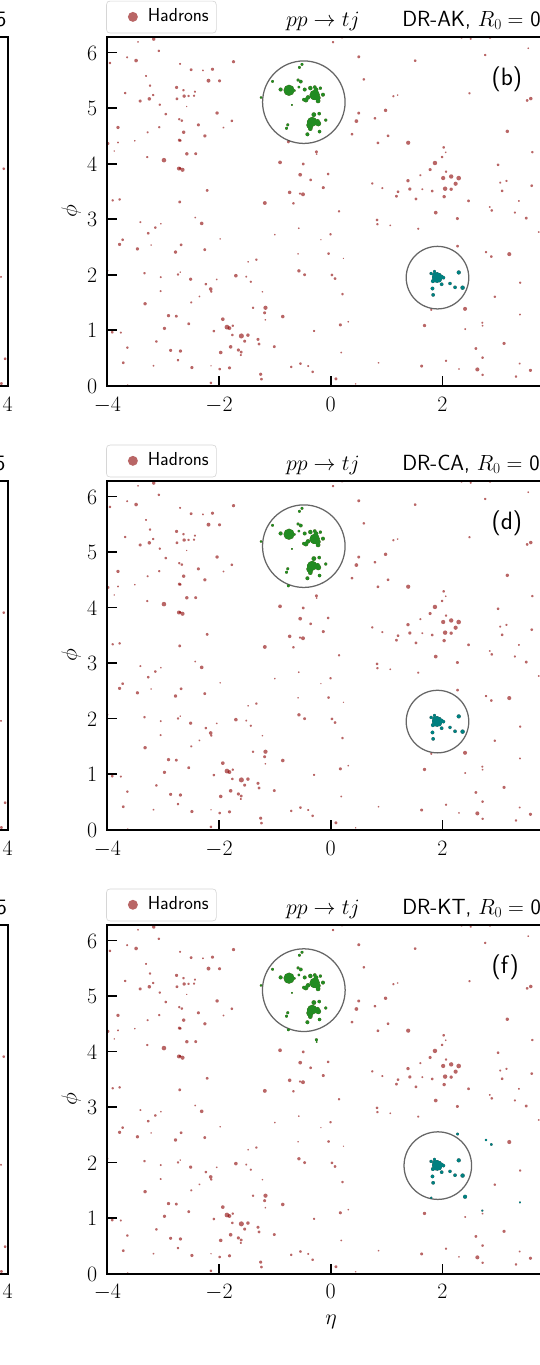
√ p T of a jet. The teal d = 0 . 5 . The right panel, from top to bottom, 0